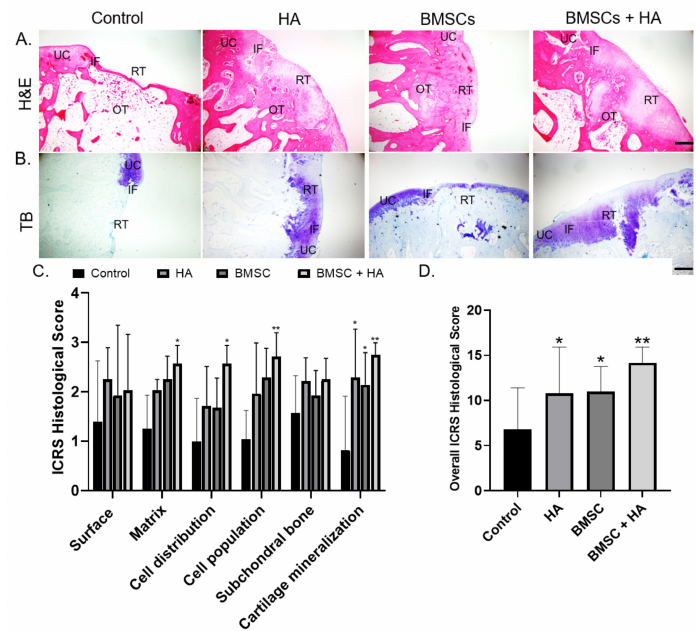
Figure 5. ( A ) Hematoxylin and eosin (H&E) staining of histological sections of representative defects from the control group and the three treatment groups treated with hyaluronic acid (HA), bone-marrow-derived stem/stromal cells (BMSCs), and combined BMSCs and HA. In untreated controls, the defect was obvious without notable regenerated tissue. In the treatment groups, more repair tissue was found filling the defects. Scale bars: 100 µ m. ( B ) Toluidine blue staining of histological sections of representative defects of the three groups. Scale bars: 100 µ m. UC, unoffended cartilage; IF, interface; RT, repaired tissue; and OT, subchondral bone. ( C , D ) International Cartilage Repair Society scores evaluating repair tissue in the control, HA, BMSC, and combined BMSC and HA groups at 12 weeks. The bars indicate the mean ± standard deviation ( n = 6) for each group. * p < 0.05 and ** p <